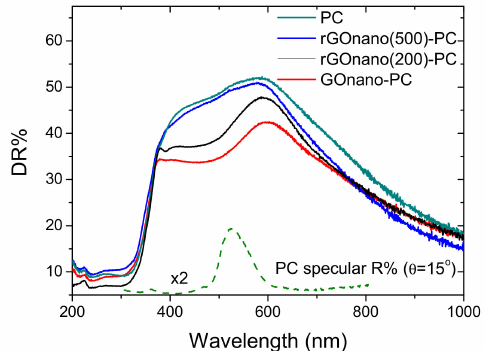
Figure 4. UV-VIS di ff use reflectance (DR%) spectra of the pristine and modified photonic crystals. The dashed line shows the specular R% spectrum of the pristine PC film at 15 ◦ incident angle.